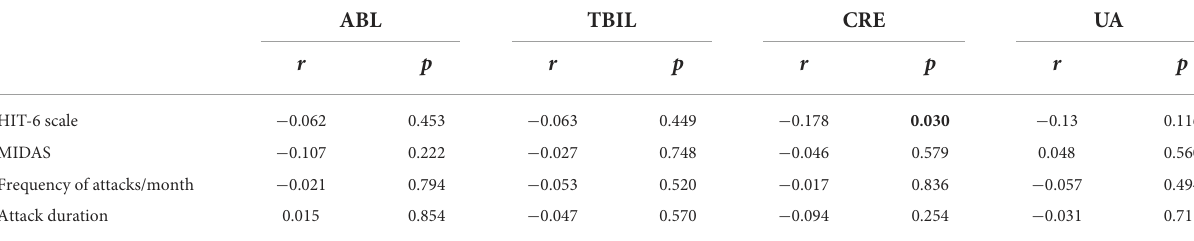
TABLE 5 Correlation between antioxidant blood variables and clinical characteristics of